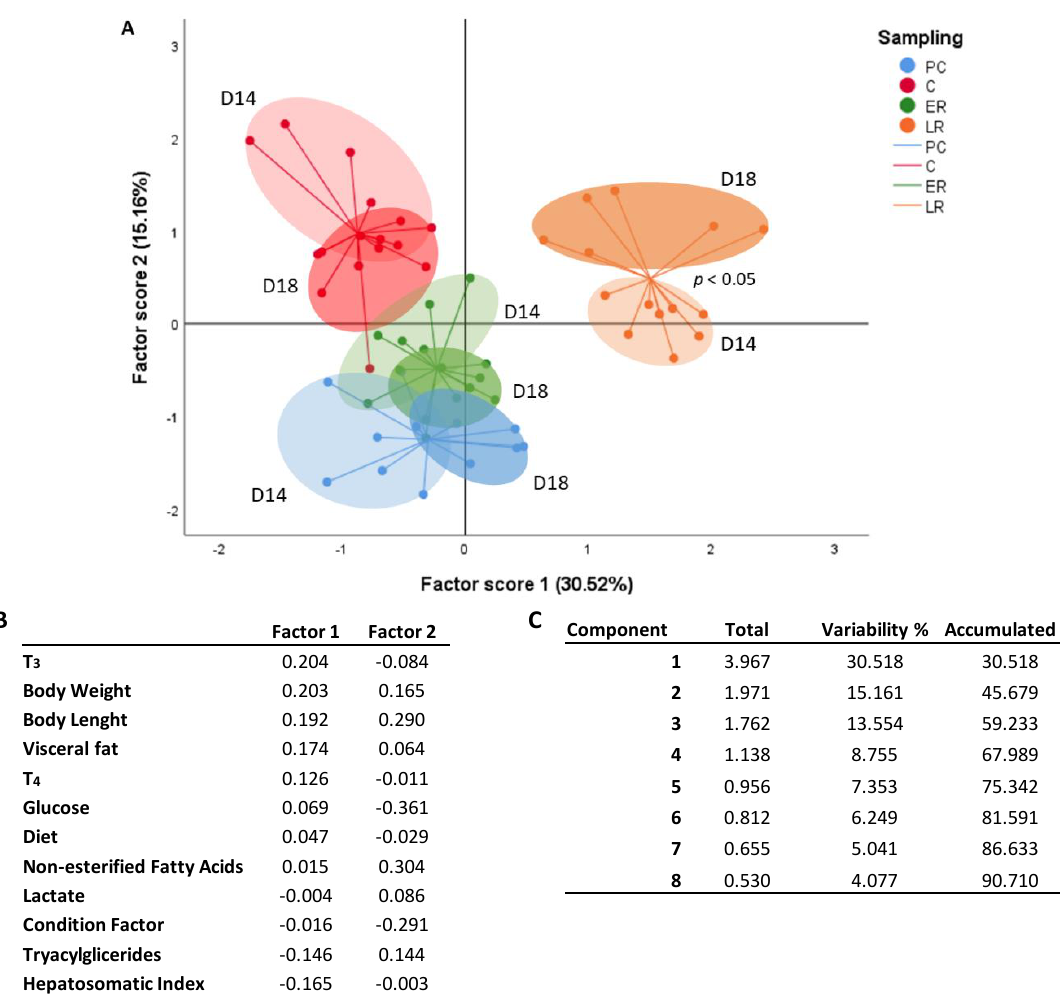
Figure 5. Principal Component Analysis (PCA) plot of body parameters, plasma metabolites and plasma thyroid hormones throughout thermal fluctuation and dietary lipid challenges. Data from body performance (body weight, body length, visceral fat, condition factor and hepatosomatic index) correspond to data reported in [8]. Data from plasma markers (glucose, lactate, triacyclglycerides, non-esterified fatty acids) correspond to data reported in [16]. ( A ) Coloured clouds indicate each thermal period (Pre-Cold, PC; Cold, C; Early Recovery, ER; Late Recovery, LR). Compact coloured clouds correspond to D18 individual fish and blur coloured clouds correspond to D14 individual fish. Factors 1 and 2 represent the first and second principal components. Axis parentheses indicate the factors explained variance. ( B ) Indicate the factor contribution of each variable and ( C ) indicate the component variance accumulation to a maximum of 90%.